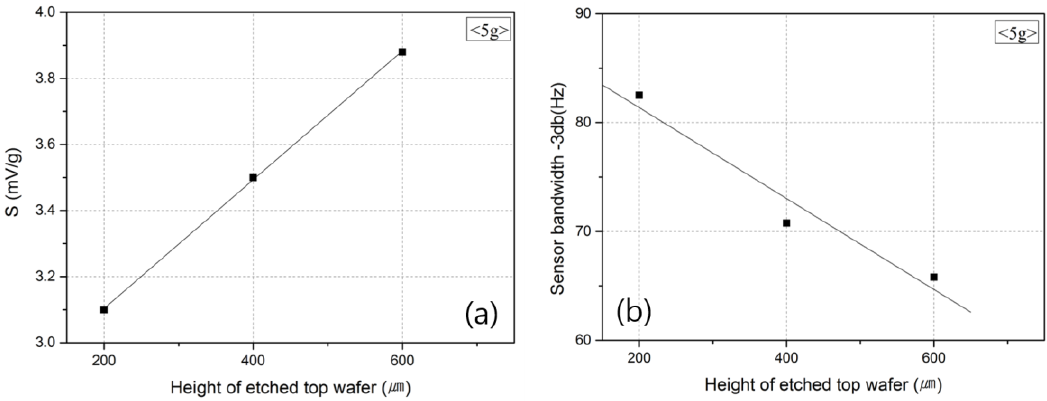
Figure 9. Output ( a ) sensitivity and ( b ) frequency of the accelerometer according to the height of the etched top wafer.